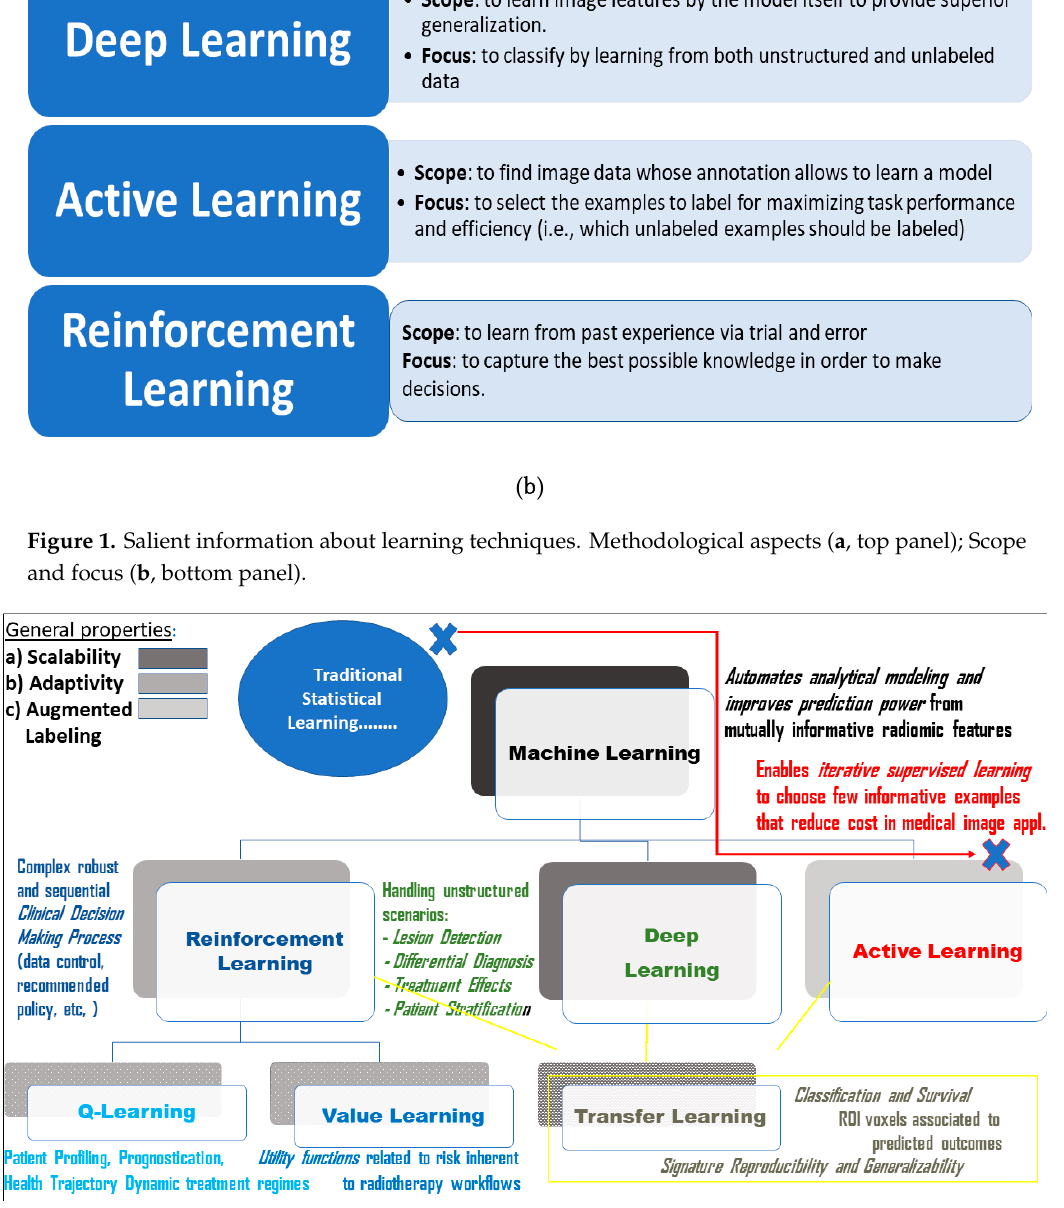
Figure 2. Significance of learning for Radiomics. General properties (gradients boxes) and distinct characteristics (floating text). Note: the aggregate black color assigned to ML is due to multiple properties.